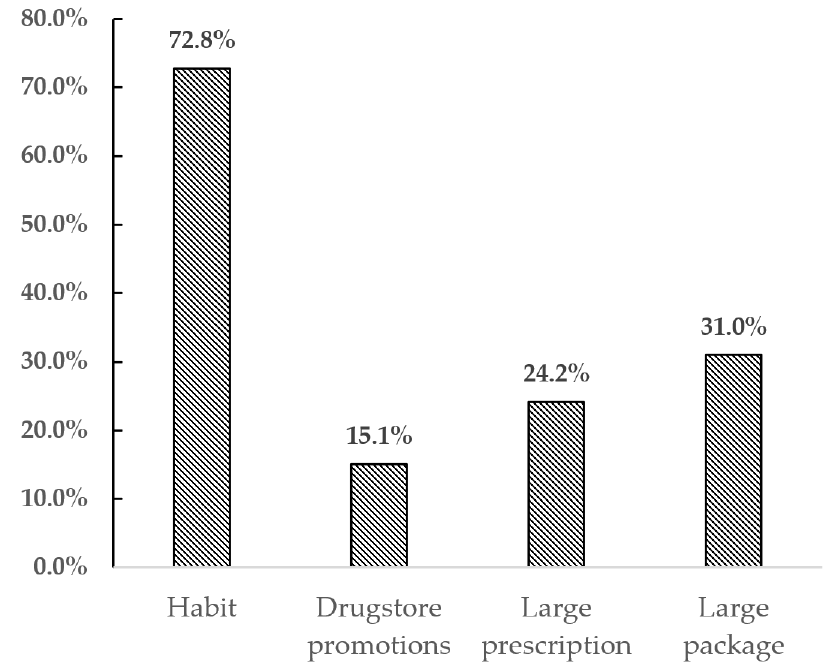
Figure 3. Reasons to store drugs in